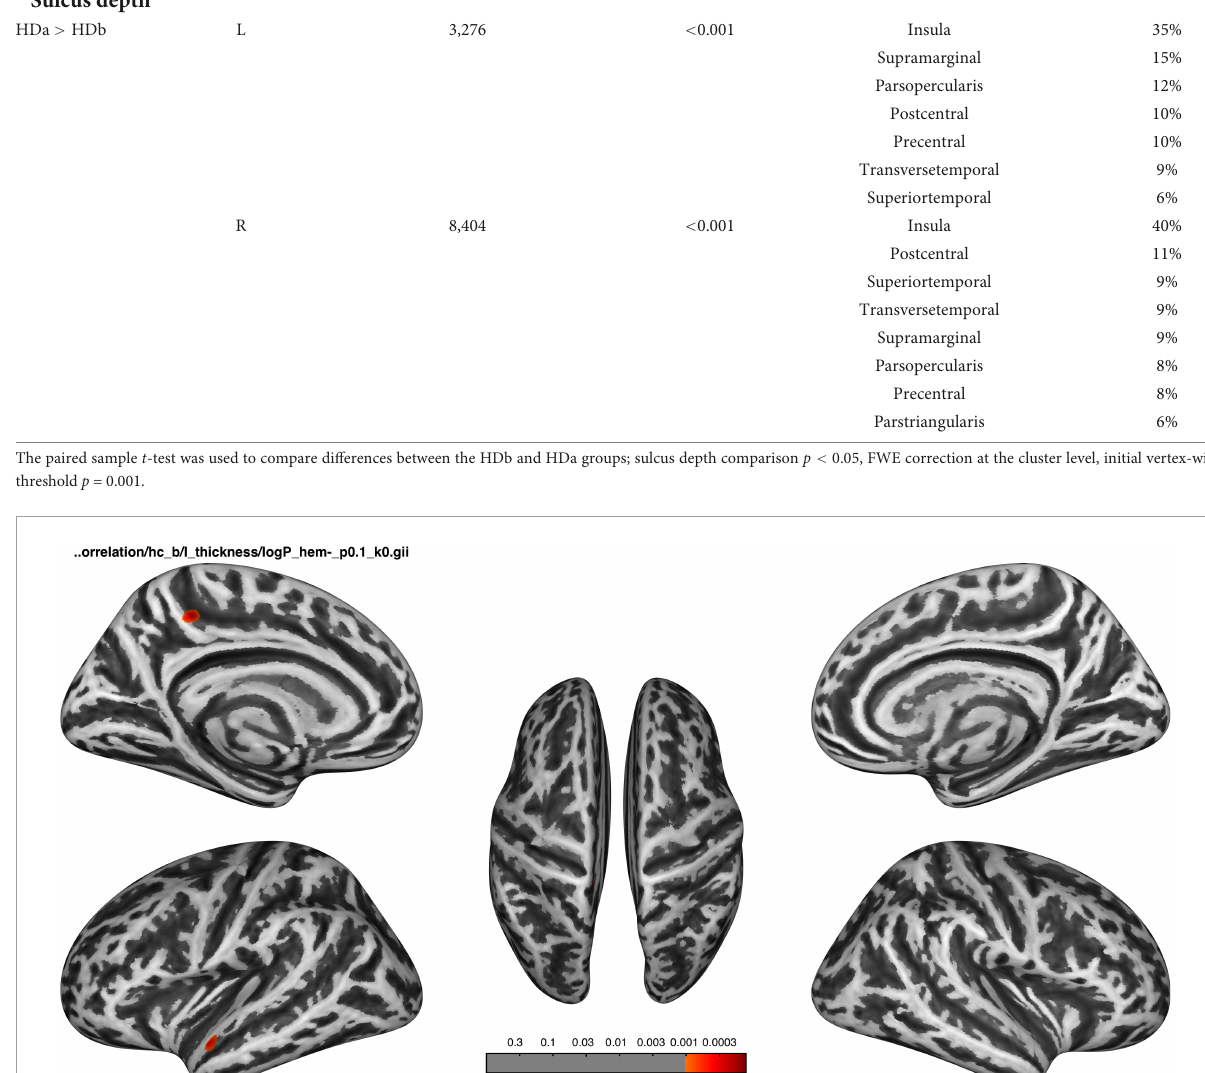
TABLE 4 Regions showing cortical sulcus depth differences among the before HD (HDb), after HD (HDa), and healthy control (HC) groups. Side Overlap of atlas region Number of vertexes P-value Region Proportion